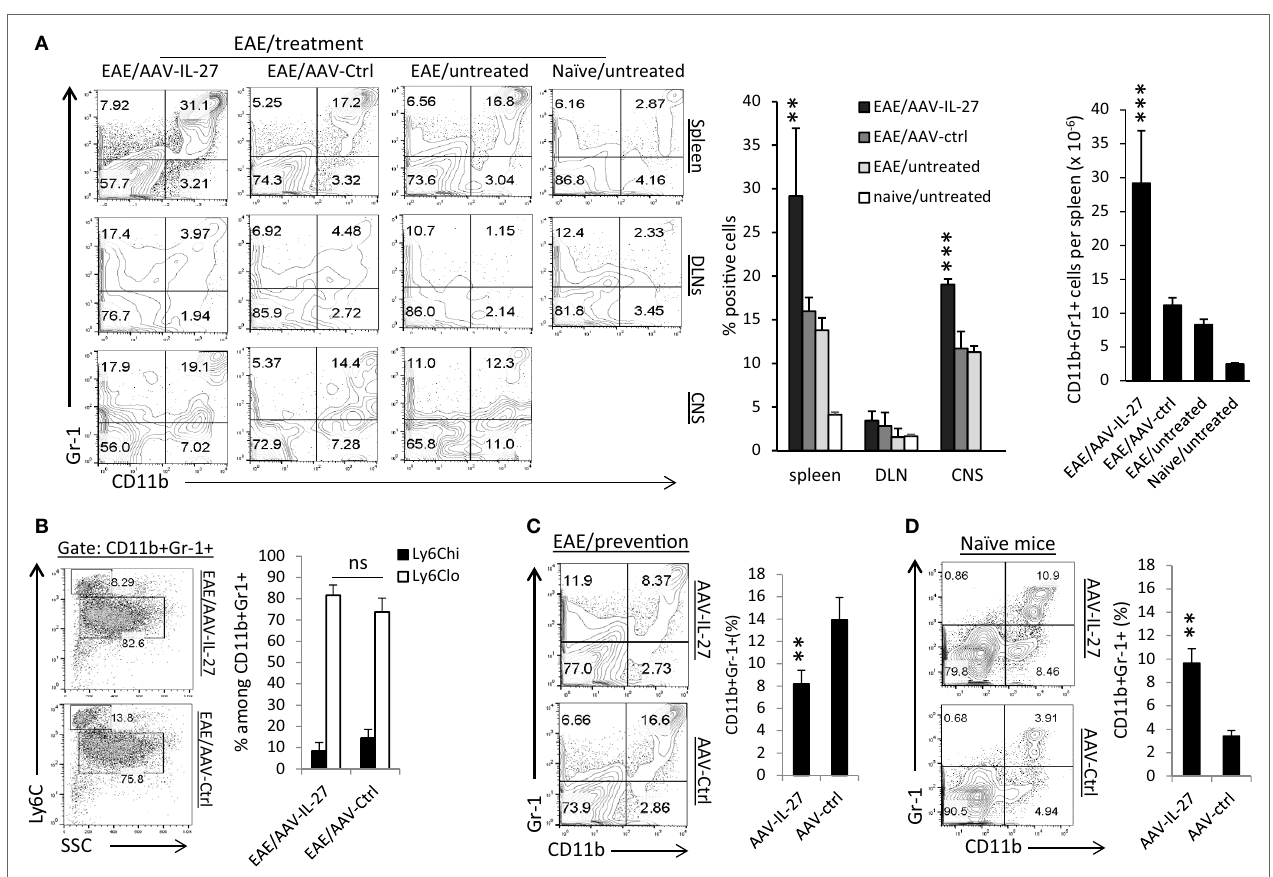
FigUre 6 | The effects of adeno-associated viral vector (AAV)-delivered interleukin-27 (IL-27) on the expansion of CD11b + Gr-1 + myeloid cells. (a) C57BL6 mice were immunized with MOG peptide/CFA and pertussis toxin. Ten days after immunization, when the first symptoms of experimental autoimmune encephalomyelitis (EAE) appeared, mice ( n = 5/group) were treated with AAV-IL-27 or AAV-ctrl virus i.m. or left untreated. By day 30 after EAE induction, mice were sacrificed, and myeloid cells in spleens (upper panel), draining lymph nodes (DLNs; middle panel) and spinal cords [central nervous system (CNS)] were analyzed by flow cytometry. Percentages and absolute numbers (spleen) of CD11b + Gr-1 + myeloid cells were also quantified (right panel). Data shown represent two experiments with similar results. ** P < 0.01; *** P < 0.001 by one way ANOVA test. (B) Subsets of myeloid cells in AAV-IL-27 or AAV-ctrl virus-treated mice with EAE. Mice ( n = 6–7/group) were induced for EAE and treated as described above. By day 30 after EAE induction, mice were sacrificed, and spleen cells were stained for CD11b, Gr-1, and Ly6C, and were analyzed by flow cytometry. Statistical analysis was performed using the unpaired Student’s t -test. * P < 0.05. Data shown represent three experiments with similar results. (c) C57BL6 mice ( n = 5/group) were injected with AAV-IL-27 or AAV-ctrl vectors i.m. at a dose of 2 × 10 11 DRP/mouse. One week later, mice were induced for EAE. Two weeks after EAE induction, mice were sacrificed and spleen cells were analyzed for the expansion of CD11b + Gr-1 + myeloid cells by flow cytometry. ** P < 0.01 by Student’s t -test. Data shown represent two experiments with similar results. (D) C57BL6 mice ( n = 5/group) were injected